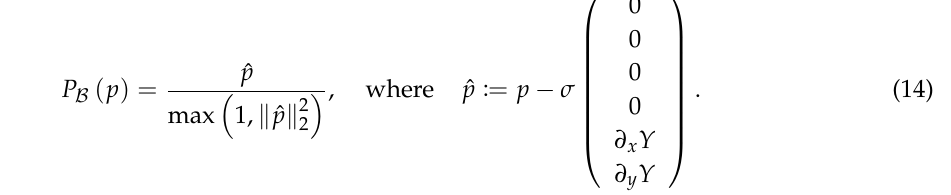
Algorithm 2 Minimization of